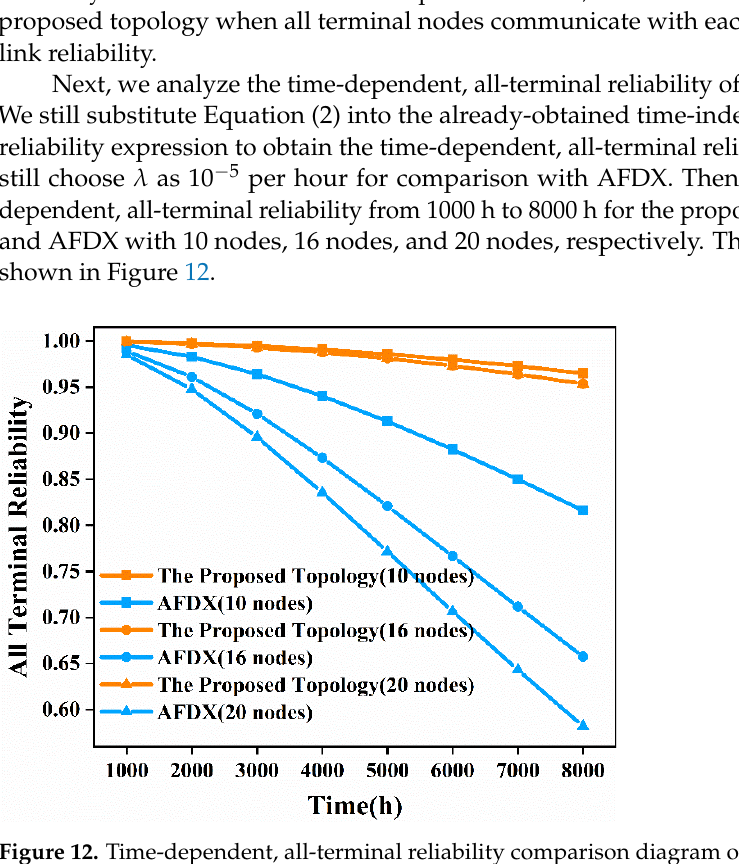
Figure 12. Time ‐ dependent, all ‐ terminal reliability comparison diagram of the proposed topology Figure 12. Time-dependent, all-terminal reliability comparison diagram of the proposed topology and AFDX in the three scenarios. and AFDX in the three